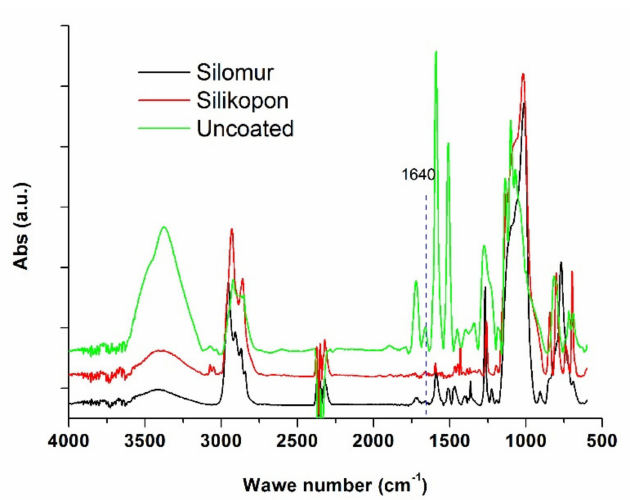
Figure 6. IR spectrum of Silomur, Silikopon EF, and uncoated samples at the initial time.